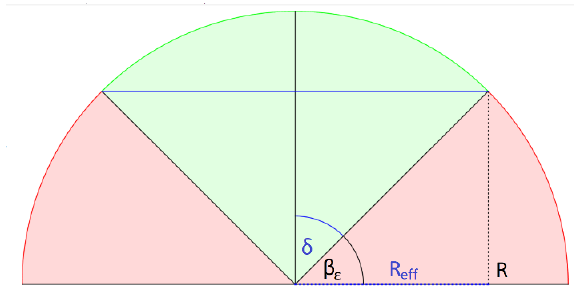
Figure 1 . The interval under consideration on the circle of radius R is depicted in green. The e(cid:11)ective radius R e(cid:11) = R cos( (cid:12) (cid:15) ) corresponds by the de(cid:12)nition of the cosine (dashed blue line) to the radius, where the points of the interval are